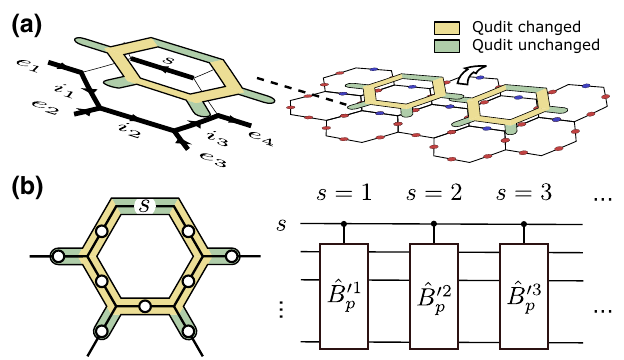
FIG. 3. The construction for general string-net models. (a) During the construction, C- ˆ B s only acts on the subspace p shown on the left; here, i 1 , i 2 , i 3 , e 1 , e 2 , e 3 , and e 4 label all the allowed strings under branching rules. s is the state of the repre- sentative qudit. The arrows indicate the convention for the string orientation. One can prepare general string-net states on a honey- comb lattice by applying C- ˆ B p row by row. Despite the overlap of the gates, they can be decomposed for parallel implementa- tion on each row. The C- ˆ B p gate is controlled by the green qudits and alters the yellow ones. The representative qudits (blue) are (cid:9) initialized in D a i | i (cid:3) . (b) The gate structure of C- ˆ B p . If the i to the rest of the representative qudit is in state | s (cid:3) , it applies ˆ B (cid:10) s p spins within the plaquette. This gate satisfies Eq. (6). We provide an explicit circuit for the gate in Appendix E. ˆ (2) We then iteratively apply the C- on each row B p